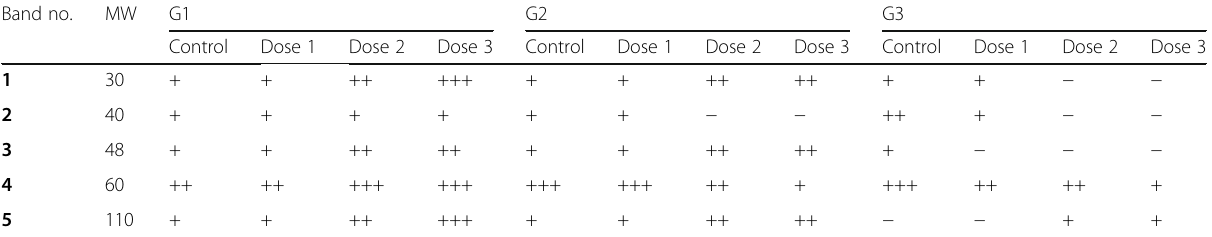
Table 7 Electrophoretic pattern of protein extracted from G1, G2, and G3 cultivars under control and different EMS treatment Band no.